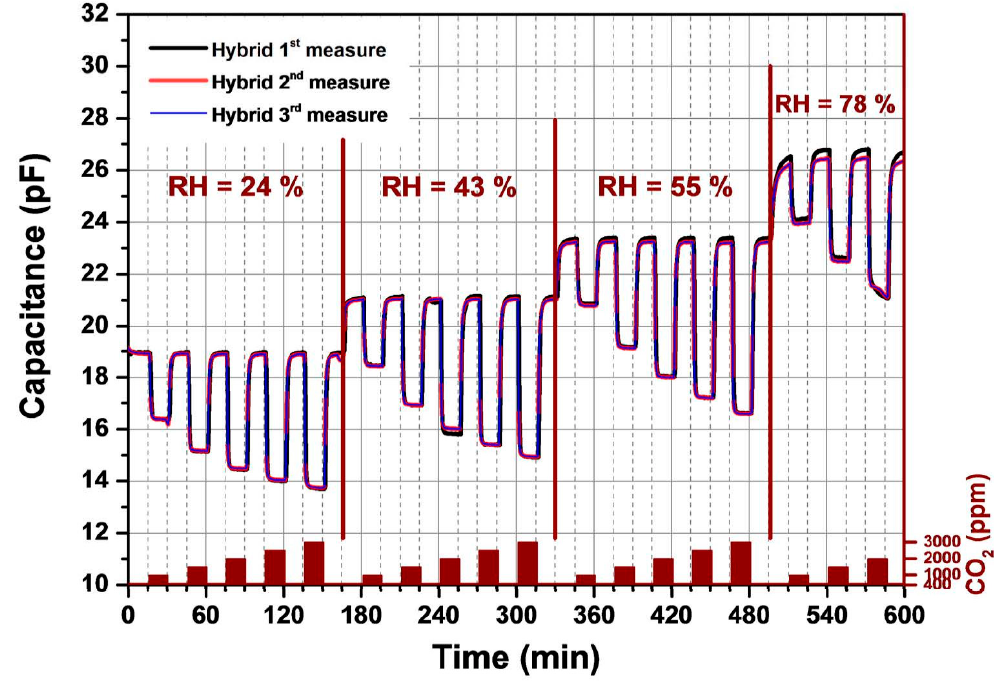
Figure 2. Capacitance response versus time of amine functionalized silica nanoparticles based CO 2 sensor. Capacitance change recorded under different CO 2 concentrations and relative humidity